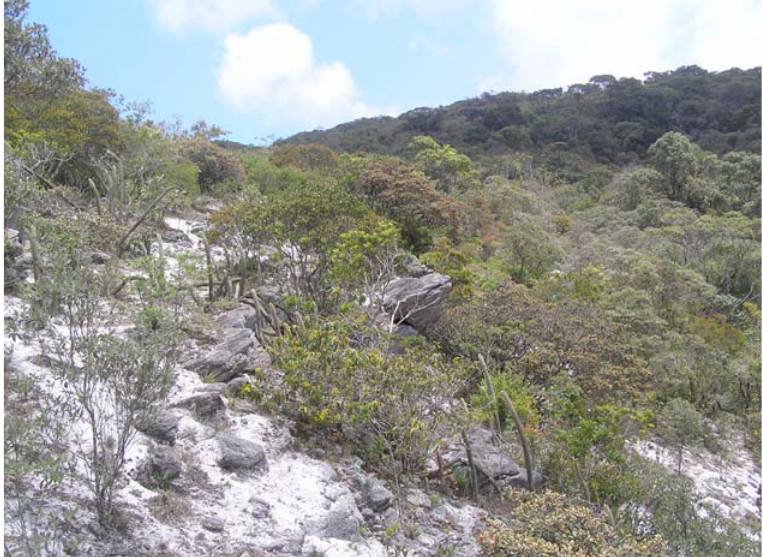
Figure 2. Campo rupestre at Serra Negra mountain, Marciano region, municipality of Rio Preto, state Minas Gerais, Brazil. Photo by Luiz Gustavo